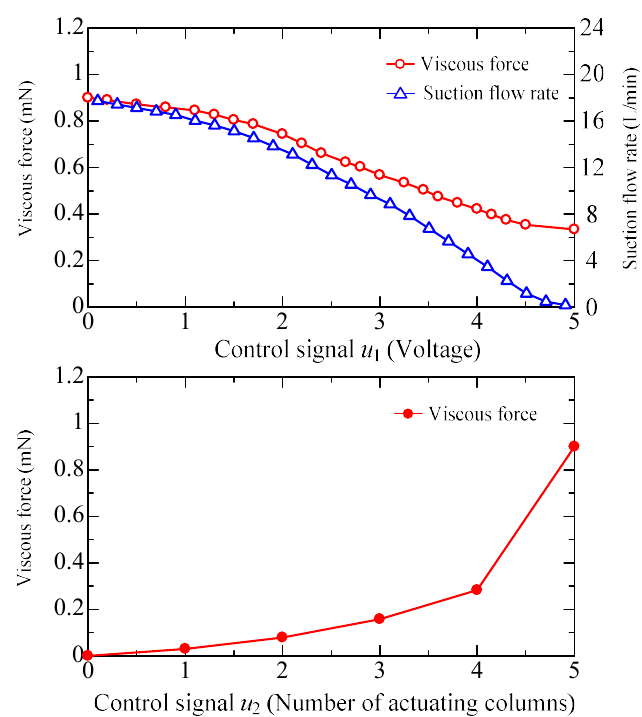
Figure 15. Relationship between the viscous force and the control signal.